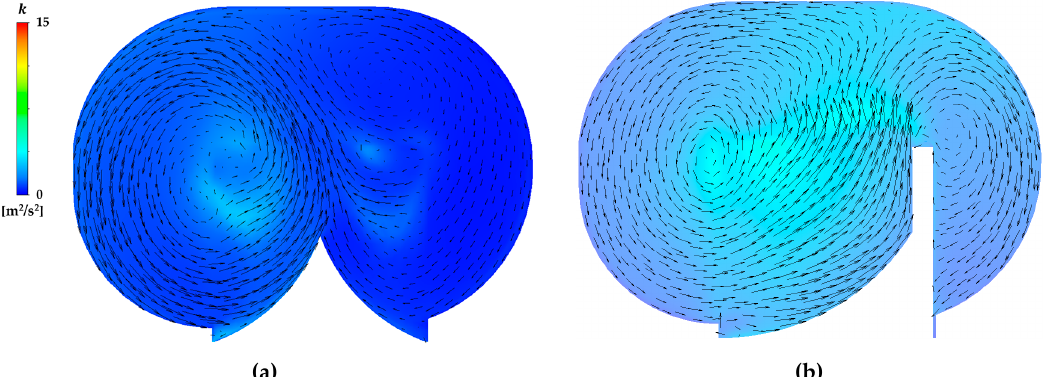
Figure 19. Velocity vectors and turbulence kinetic energy on the perpendicular plane to the rotational direction at θ = 240°: ( a ) reference pump; ( b ) optimized pump.